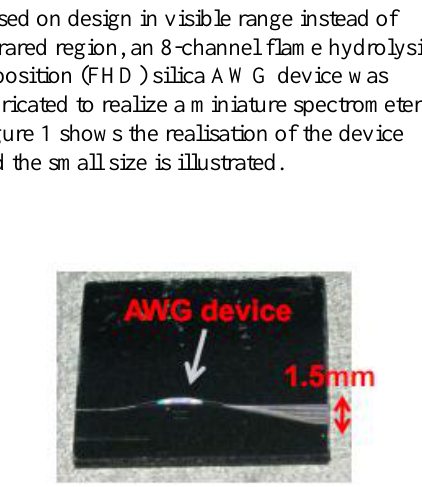
FIGURE 1: Planar AWG chip. Size of an AWG device: 12 mm(L) × 1.5 mm(W).